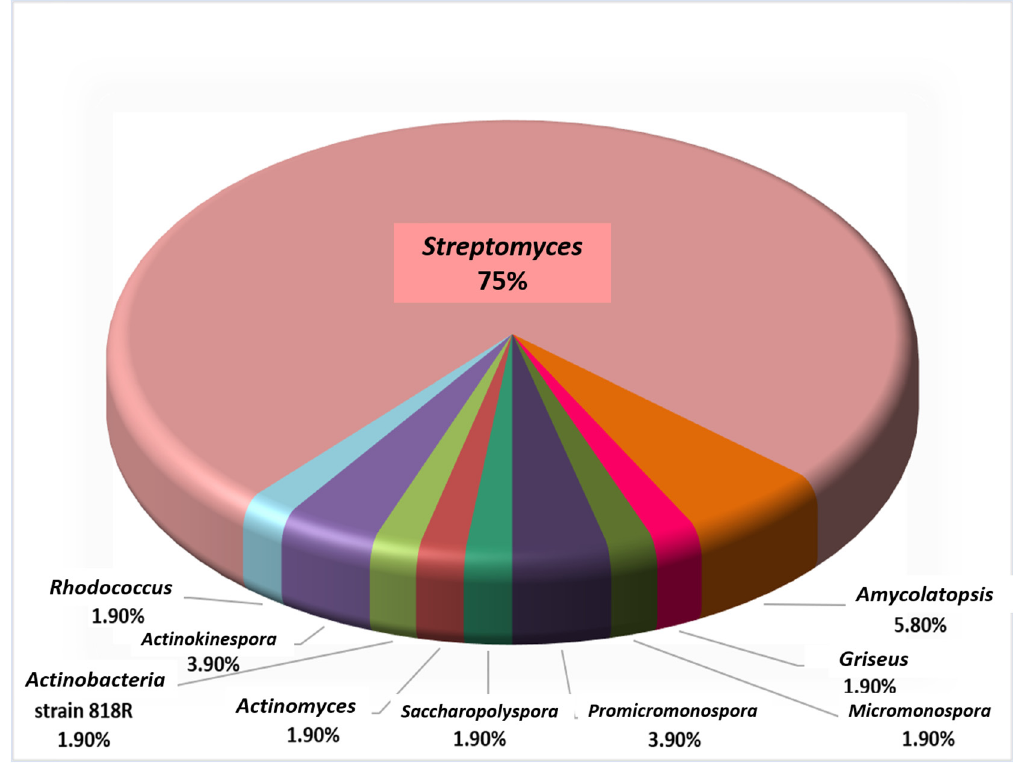
Figure 11. Diversity of actinobacterial genera detected in elicitation